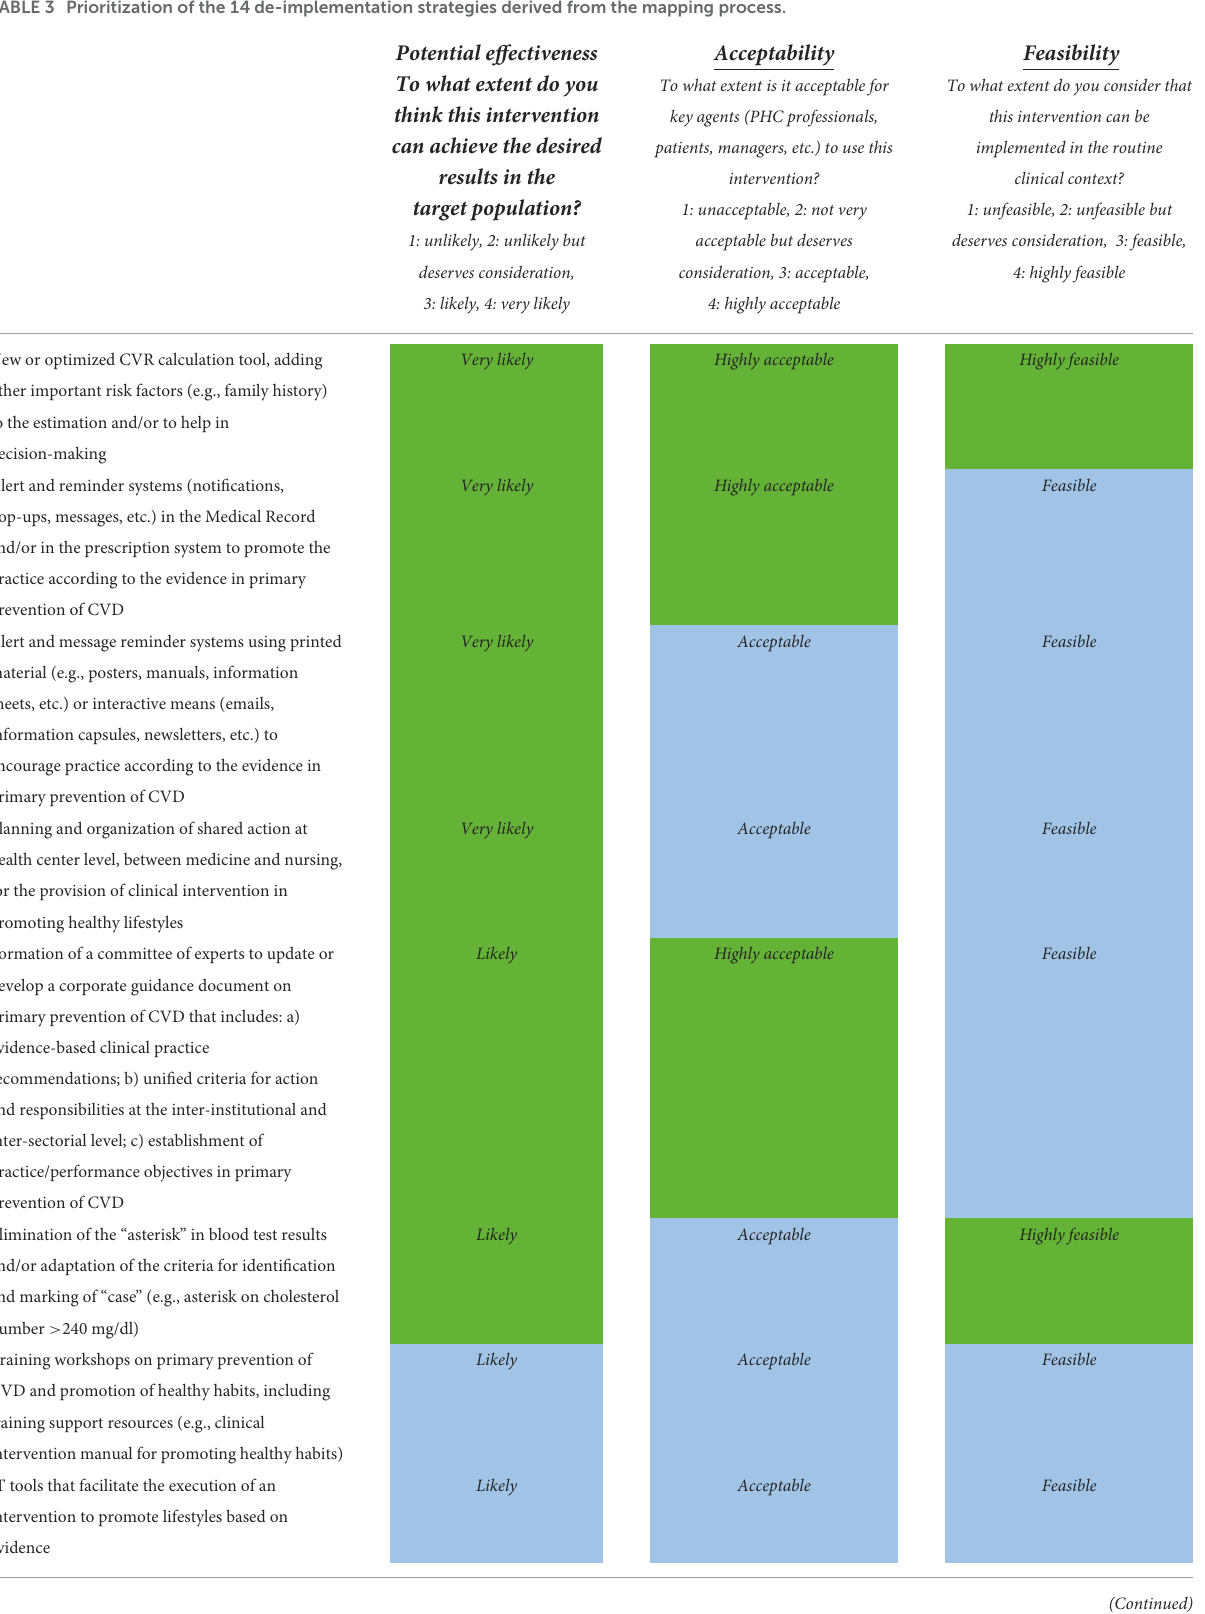
TABLE 3 Prioritization of the 14 de-implementation strategies derived from the mapping